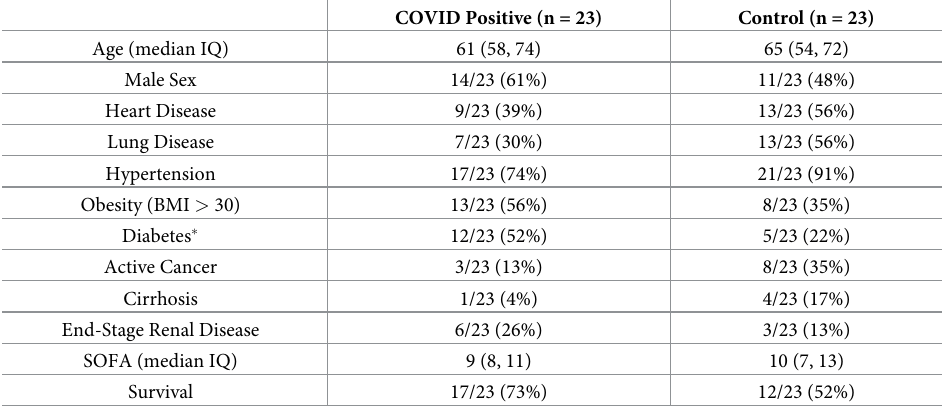
Table 1. Patient characteristics of ICU patient